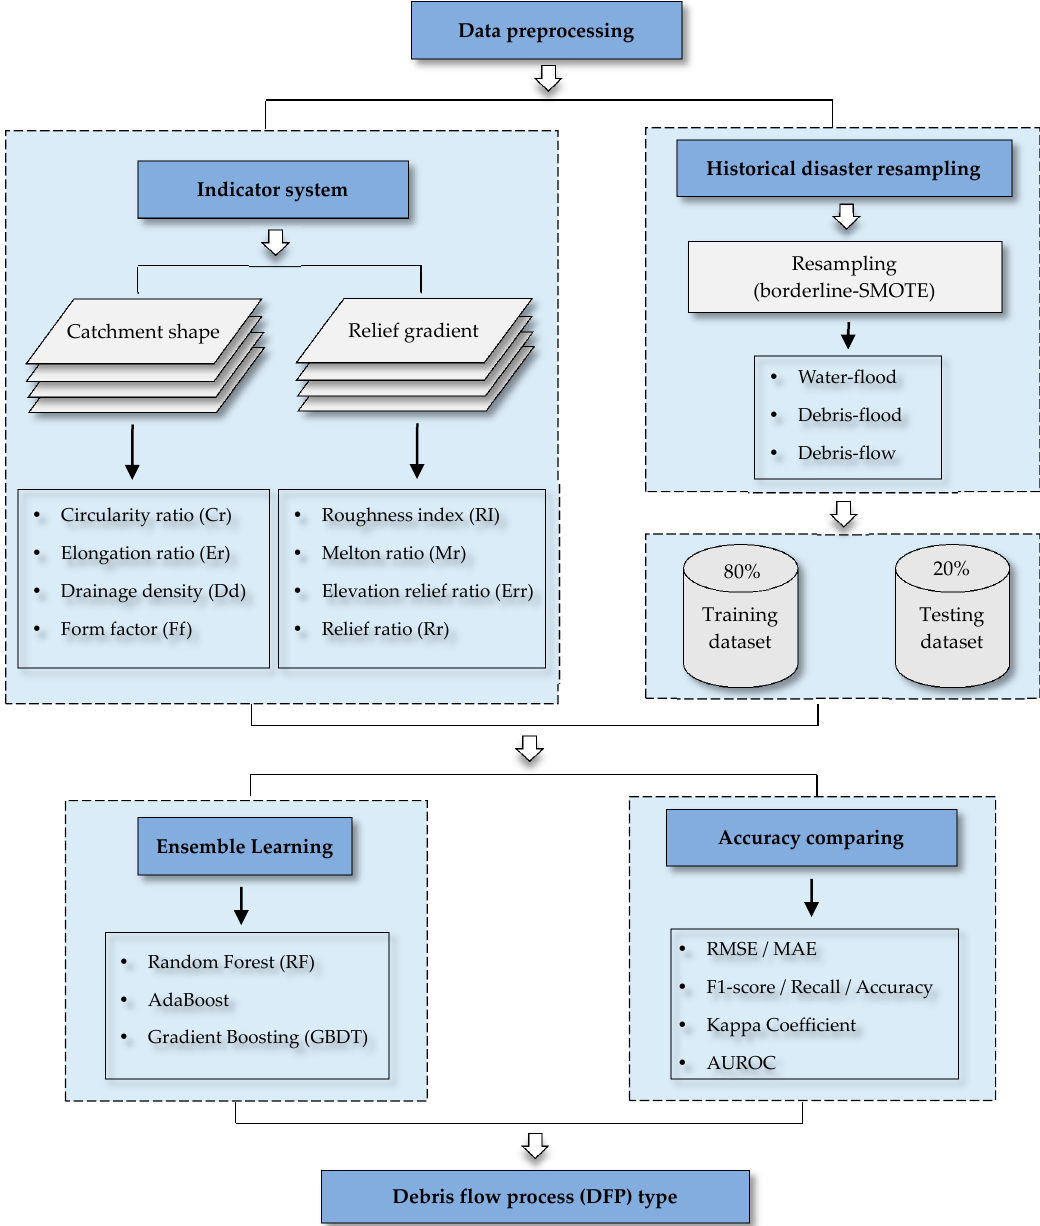
Figure 3. Flow chart of the computational process.